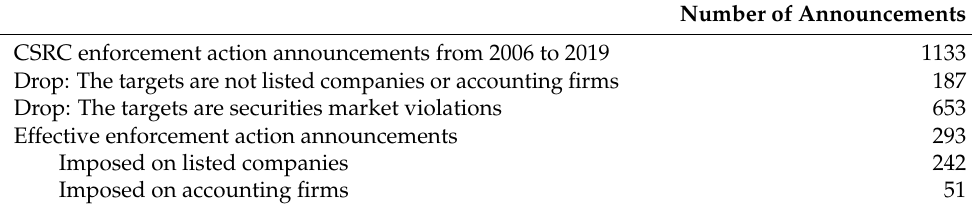
Table 1. The enforcement action announcements’ collecting process.